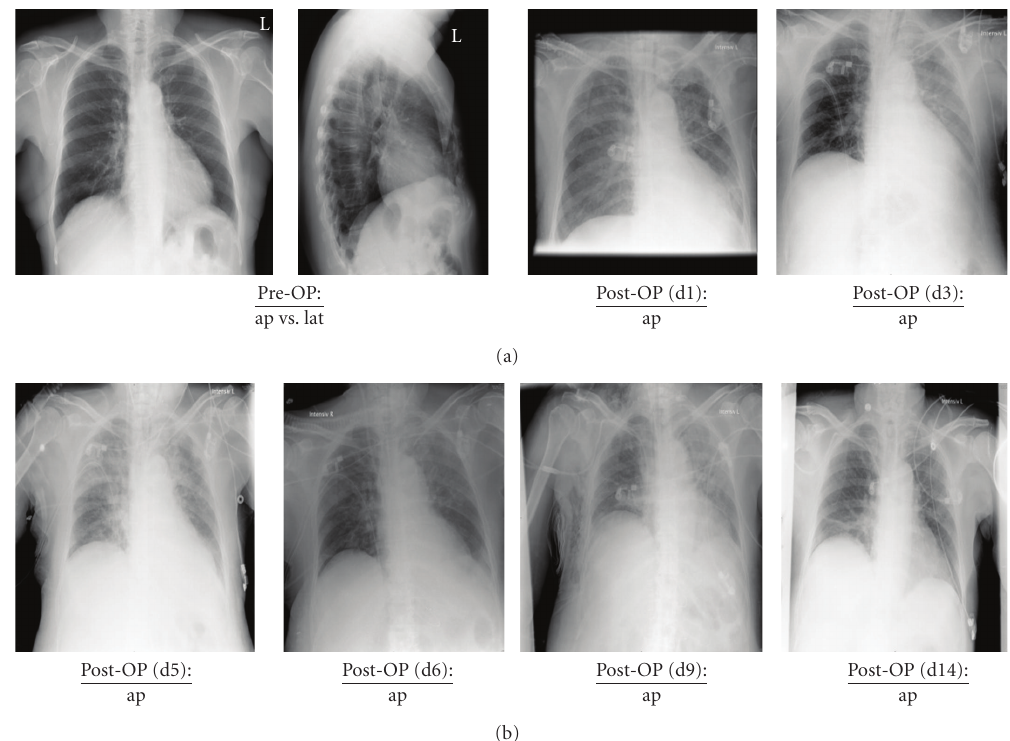
Figure 1: Chest X-ray diagnostic in the patient from preoperative (Pre-OP) until closely to the patient’s discharge from hospital at day 14. Pre-OP: preoperative; d: day; ap: anterior-posterior; lat: lateral. revealed a rapid amelioration of the respiratory